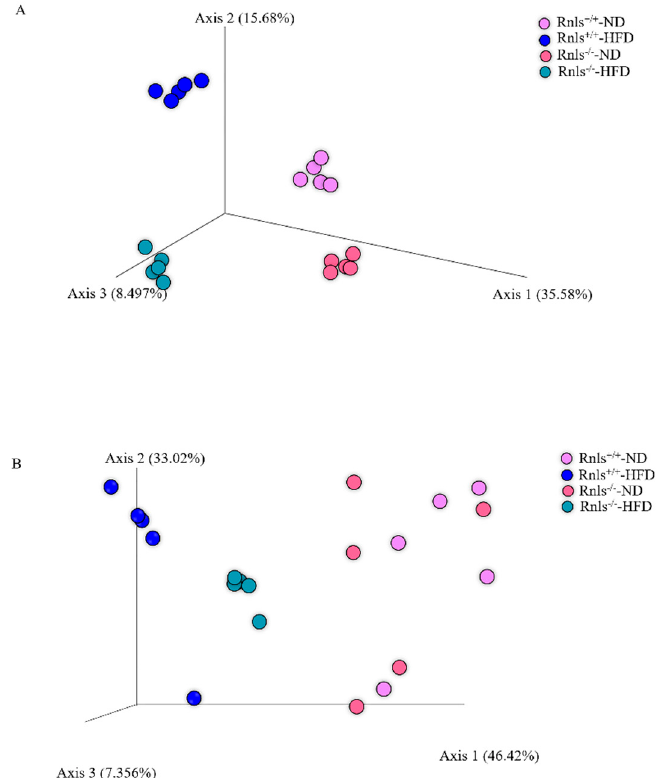
Figure 4. PCoA plot showing weighted and unweighted UniFrac distance matrices. ( A ) PCoA plots with unweighted UniFrac distance matrices illustrate distances between communities in all individual samples; different colors represent different groups. ( B ) PCoA plots with weighted UniFrac distance matrices illustrating distances between communities in all individual samples; different colors represent different groups. Generation of Emperor PCoA plots based on jackknifed_beta_diversity.py script in QIIME 2. Purple, Rnls − / − -ND, renalase gene knockout mice fed with normal diet; pink, Rnls +/+ -ND, wild-type mice fed with normal diet; blue, Rnls − / − -HFD, renalase gene knockout mice fed with high-fat diet; cyan, Rnls +/+ -HFD, wild-type mice fed with high-fat diet; PCoA, principal coordinate analysis.